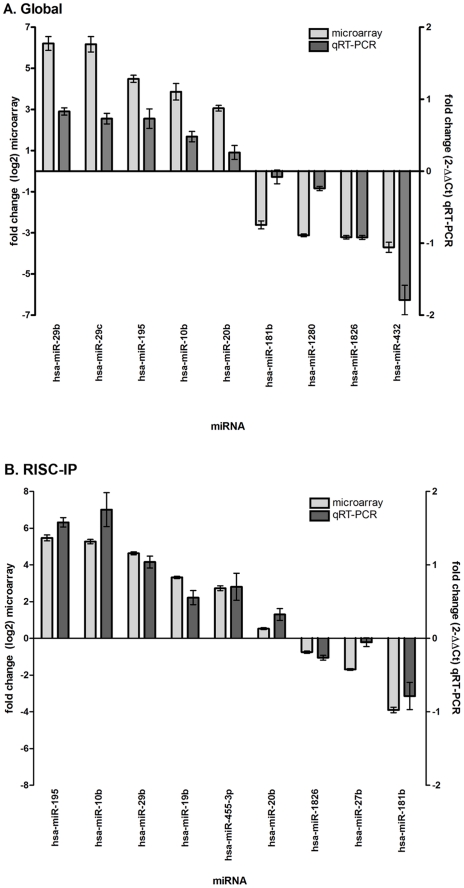
MiRNA microarray validation with qRT-PCR analysis for (A) global miRNA and (B) RISC-specific miRNA.Nine random miRNAs were selected from the miRNA microarray datasets and examined by qRT-PCR. Fold change from the miRNA microarray are given by log2 values (left y-axis, light grey bars). Fold change from the qRT-PCR was determined using the 2-ΔΔCt method and all miRNA expression values were normalized to the RNU6B endogenous control (right y-axis, dark grey bars). Error bars represent the standard deviation of the mean (SD). Note: only the general trend of up-regulation and down-regulation can be compared but the fold change (y-axis) cannot be directly compared between assays due to differences in calculation methods.